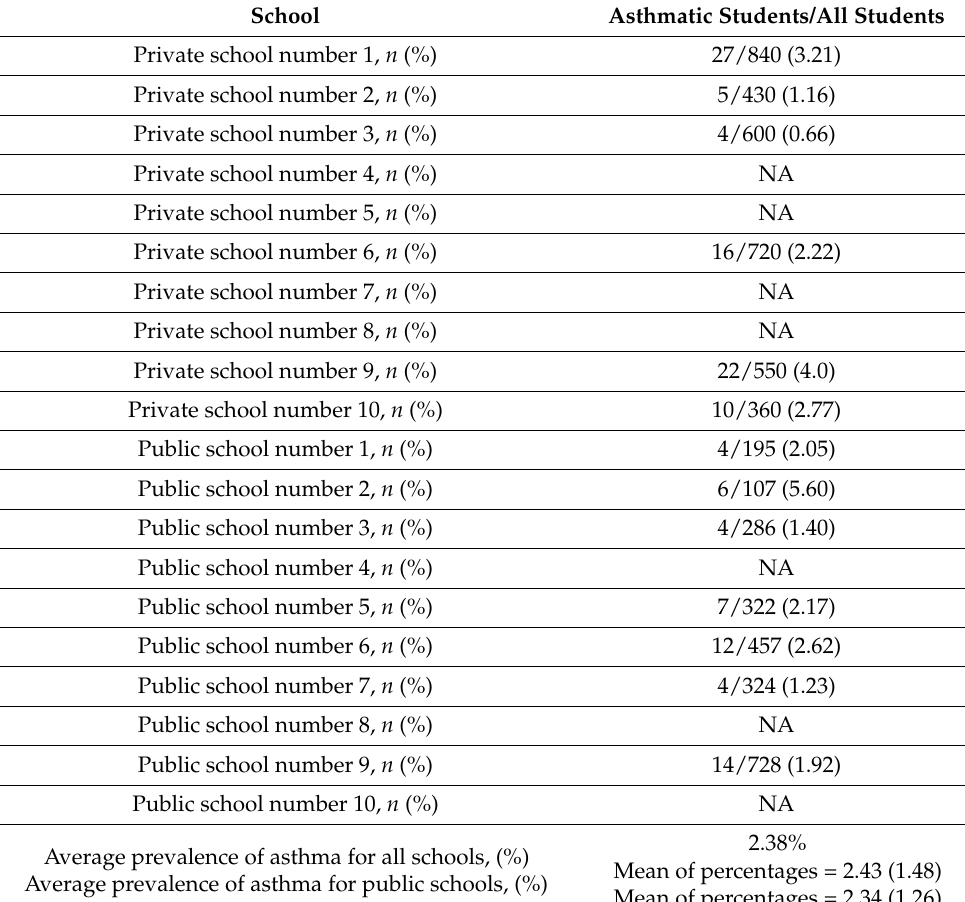
Table 1. Prevalence of asthma amongst schools